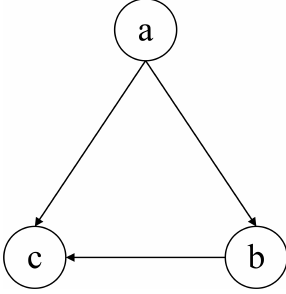
Figure 4. An example of a graphical Bayesian